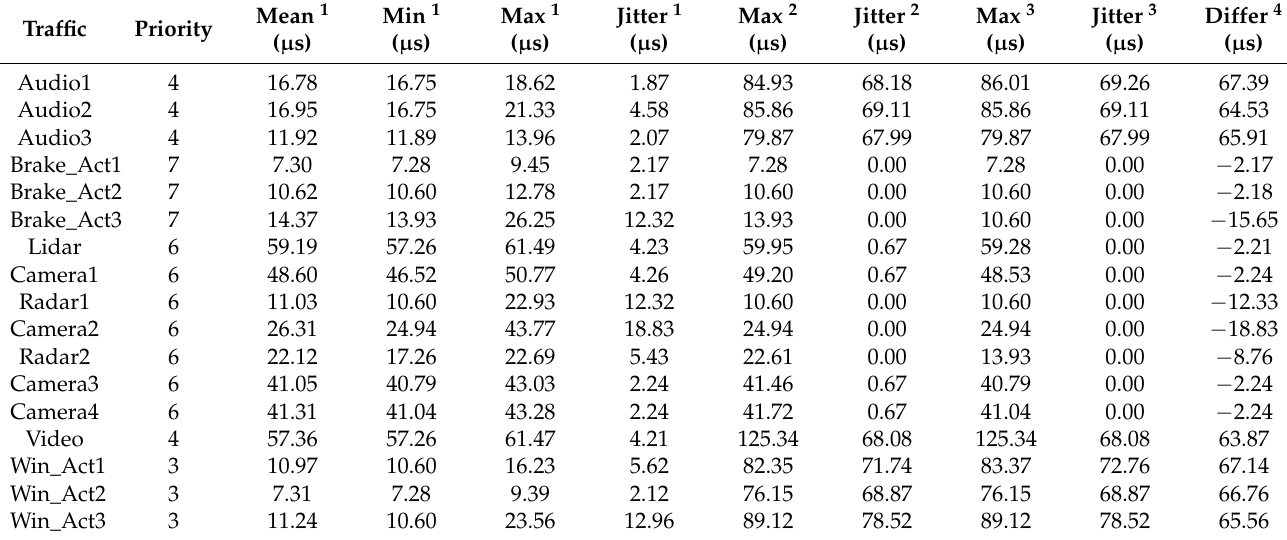
Table 7. End-to-end delay of each traffic.